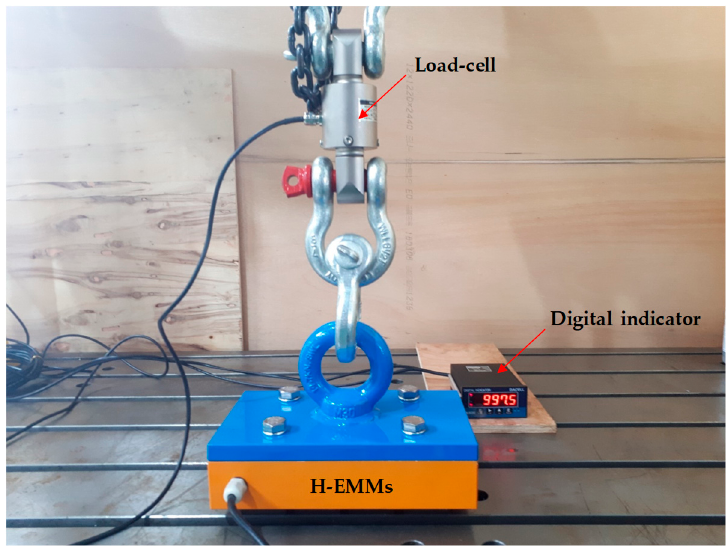
Figure 20. Prototype of the proposed model: ( a ) upper view; ( b ) bottom view.